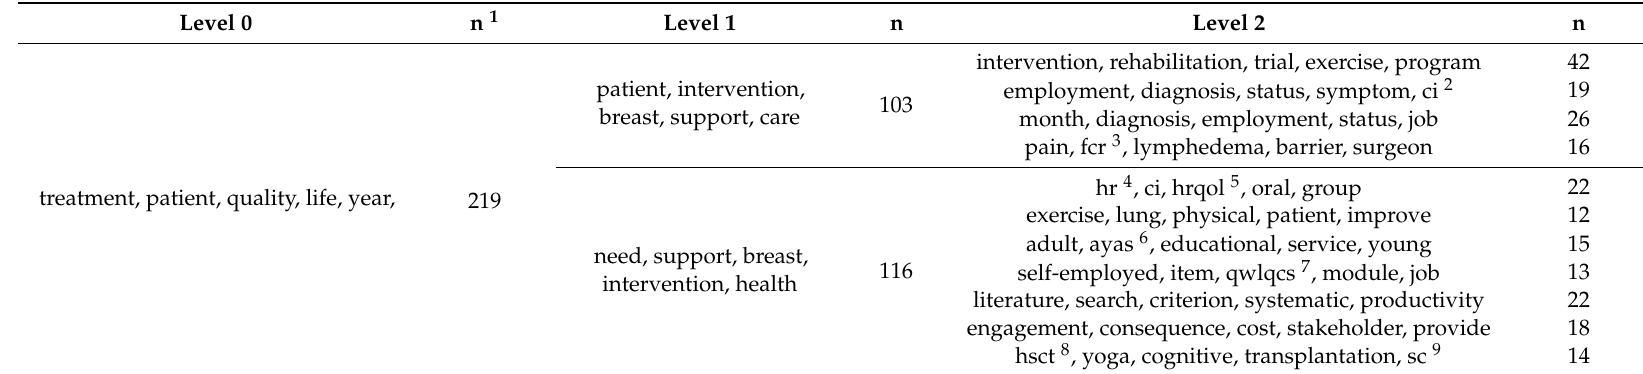
Table 2. Abstract topic